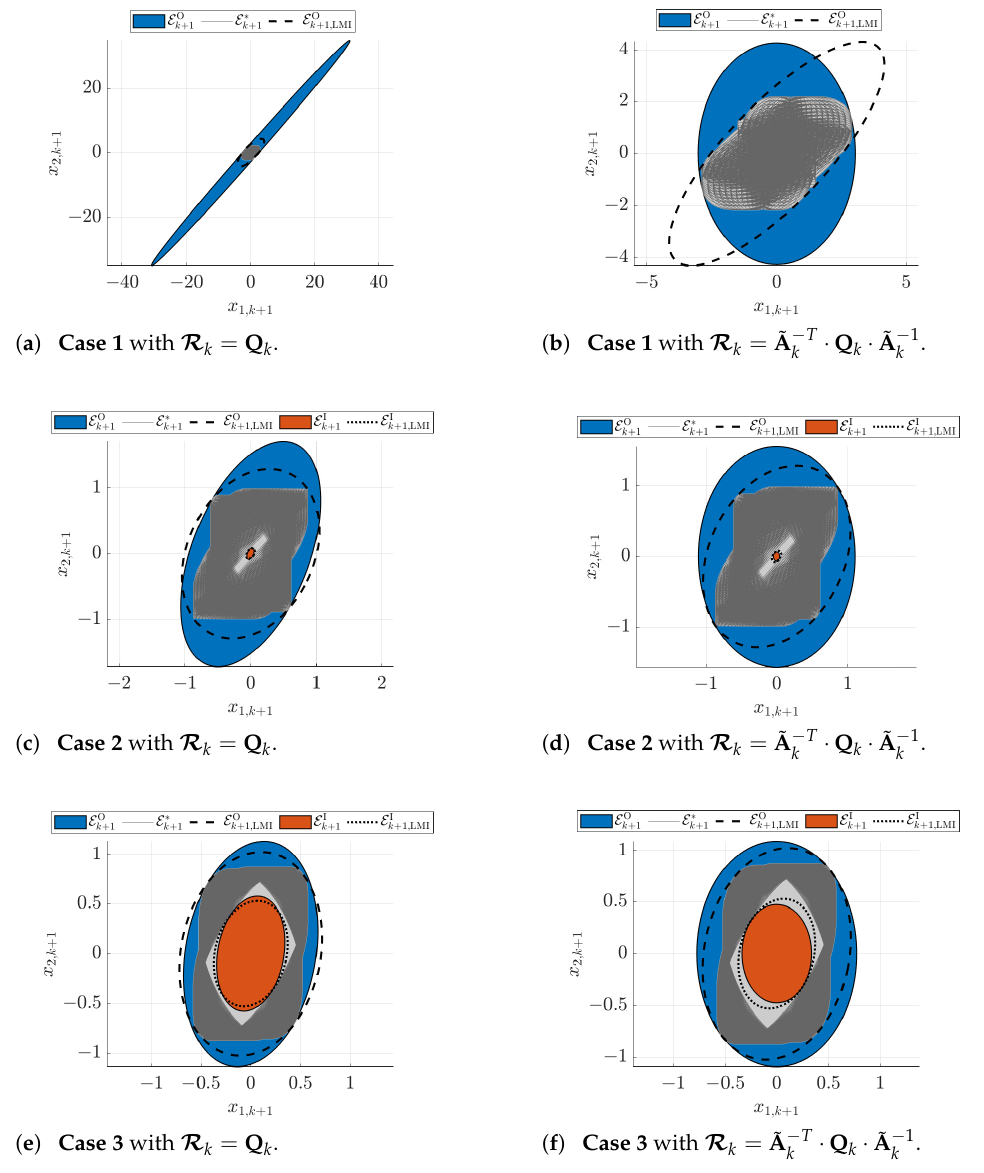
for the example (35). The exact inner k + 1